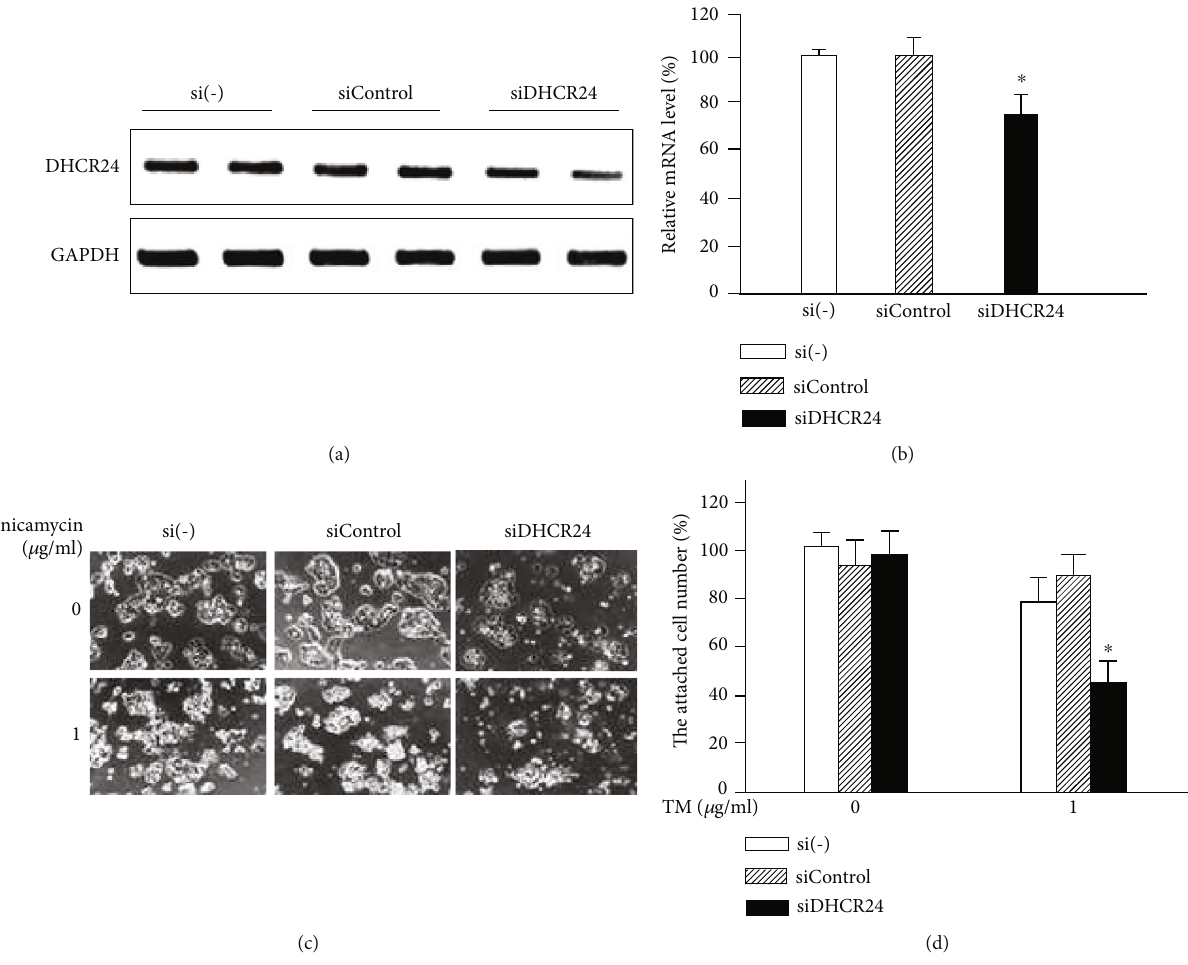
Figure 6: Downregulation of endogenous DHCR24 promotes MIN6 cell apoptosis caused by ER stress. (a) The mRNA levels of DHCR24 were measured by semiquantitative RT-PCR after infection of MIN6 cells with siControl and siDHCR24. (b) The relative mRNA levels of DHCR24 were normalized to GAPDH and calculated as percentage of the levels in the si(-) group. Mean ± S : D : ( n = 3 ); ∗ p < 0 : 05 vs. si(-) or siControl. (c) Images of MIN6 cells were taken with a phase-contrast microscope after infection with siControl and siDHCR24 followed by treatment with TM for 24h. Scale bar, 100 μ m. (d) The adherent cell number was calculated as percentage of cells in the si(-) group at 0h after TM treatment. Mean ± S : D : ( n = 3 ); ∗ p < 0 : 05 vs. si(-) or